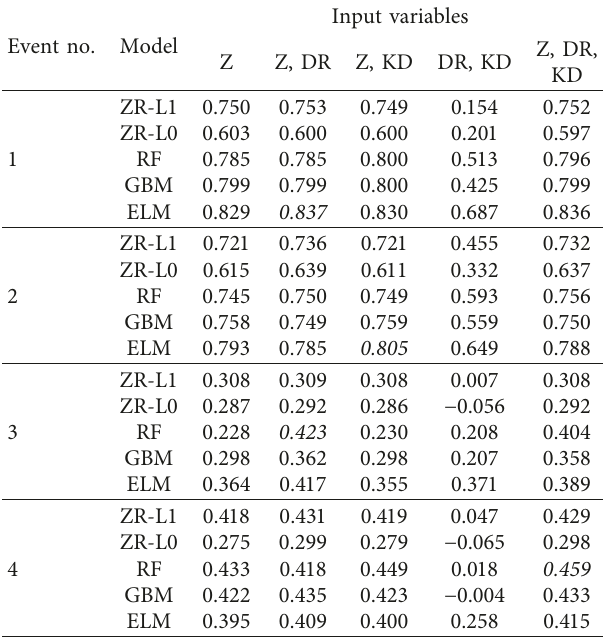
Table 4: Root-mean-square errors (RMSEs) of rainfall rates esti- mated by quantitative precipitation estimation models for selected rainfall events.